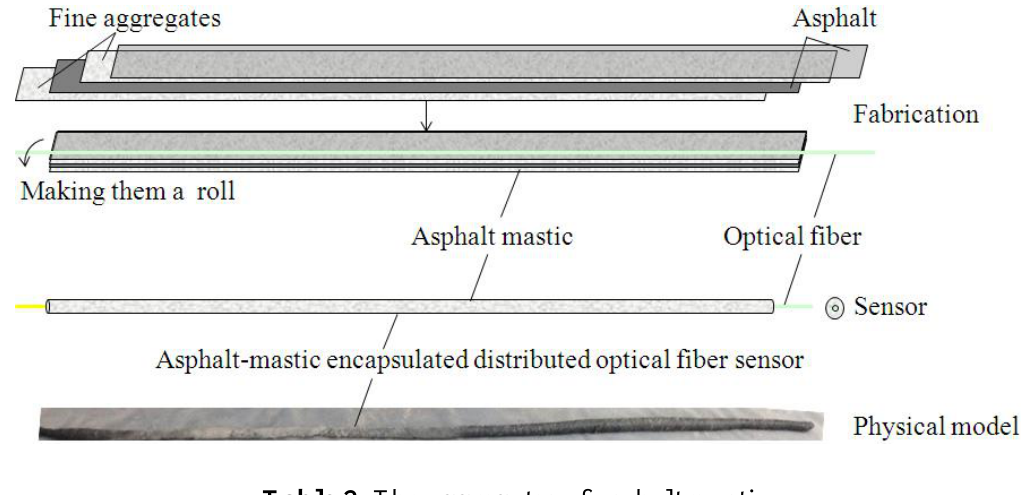
Table 2. The aggregates of asphalt